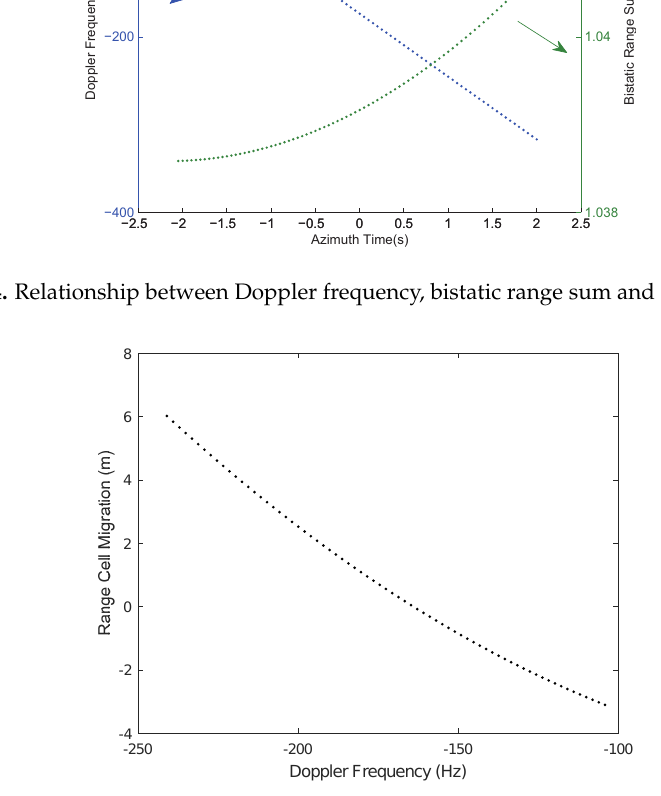
Figure 5. Relationship between RCM and Doppler